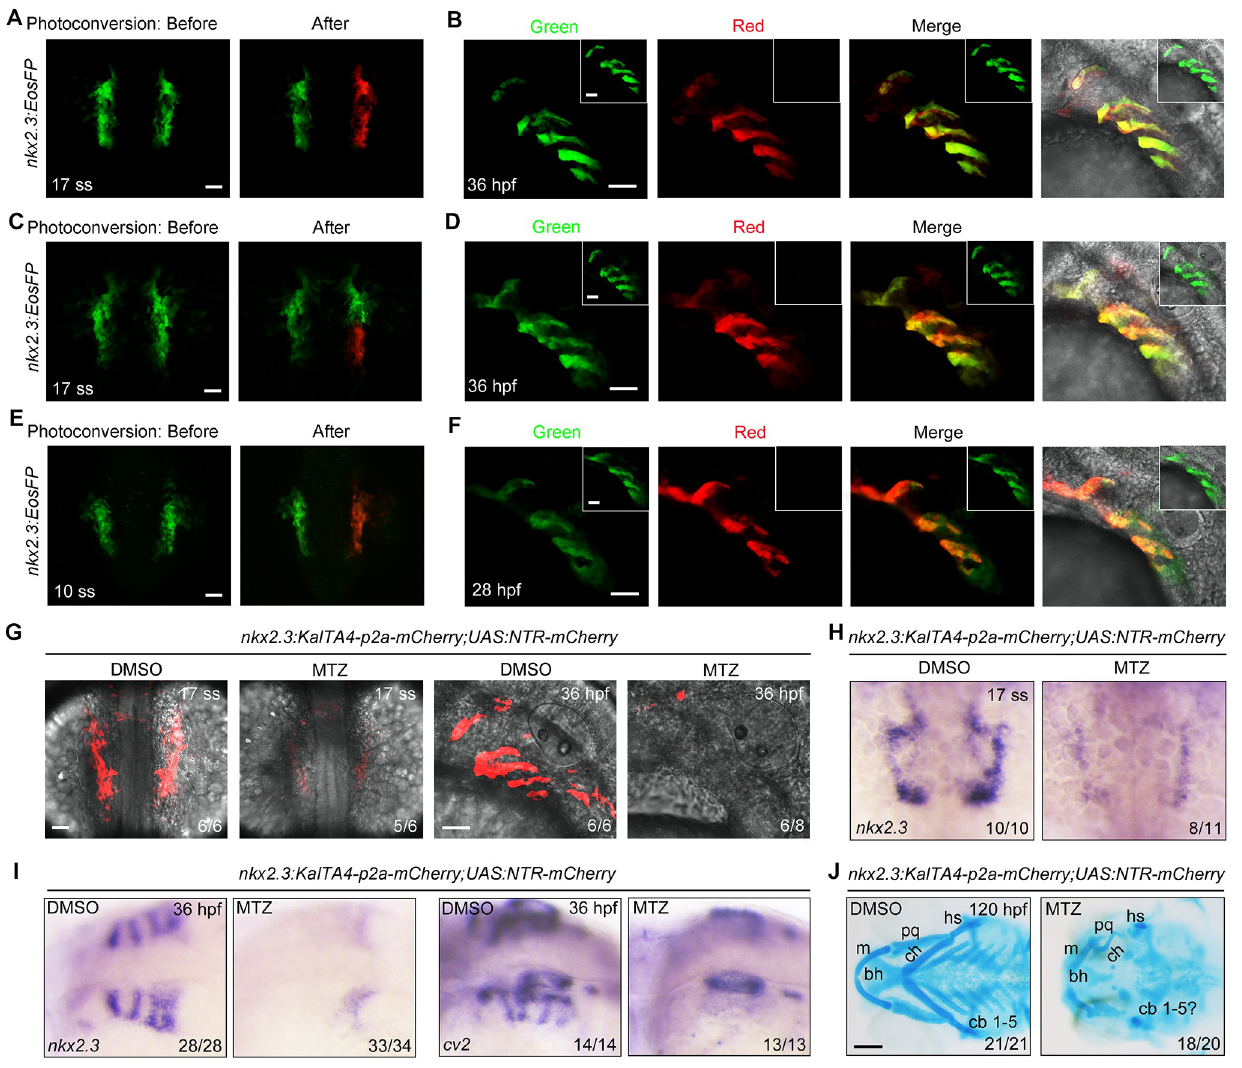
Fig 2. nkx2 . 3 + progenitors give rise to pharyngeal pouches. ( A-B ) Tg(nkx2 . 3 : EosFP) embryos at the 17-somite stage before (green) and after (red) photoconversion in the right-side nkx2 . 3 + cluster (A). At 36 hpf, embryos were imaged in the green and red channels (B). Cells in the right-side nkx2 . 3 + cluster remained un-photoconverted as an internal control and their derivatives were imaged and shown in the inset. Scale bars, 50 μ m. ( C-D ) The posterior part of the right-side nkx2 . 3 + cluster was photoconverted at the 17-somite stage (C). Images of the pharyngeal pouches in the same embryos at 36 hpf are shown in (D). Scale bars, 50 μ m. ( E-F ) Tg(nkx2 . 3 : EosFP) embryos were photoconverted in the right-side nkx2 . 3 + cluster at the 10-somite stage (E), and then these embryos were imaged in the red and green channels (inset) at 28 hpf (F). Scale bars, 50 μ m. ( G-J ) Tg(nkx2 . 3 : KalTA4-p2a-mCherry;UAS : NTR-mCherry) embryos were treated with 50 mM MTZ from the 32-cell stage to the 17-somite stage. Subsequently, these embryos were harvested at the indicated developmental stages for in vivo confocal imaging (G), in situ hybridization (H-I) and Alcian Blue staining (J). m, Meckel’s; pq, palatoquadrate; hs, hyosymplectic; bh, basihyal; ch, ceratohyal; cb, ceratobranchial. Scale bars, in panel G, 50 μ m; in panel J, 100 μ m.